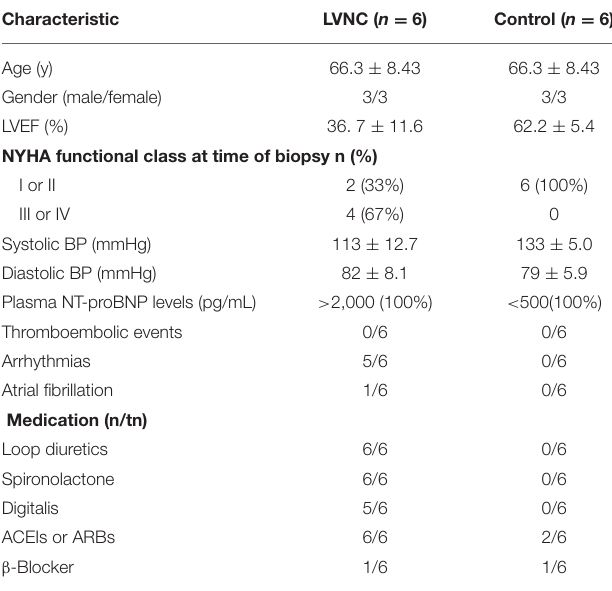
TABLE 1 | Clinical characteristics of study